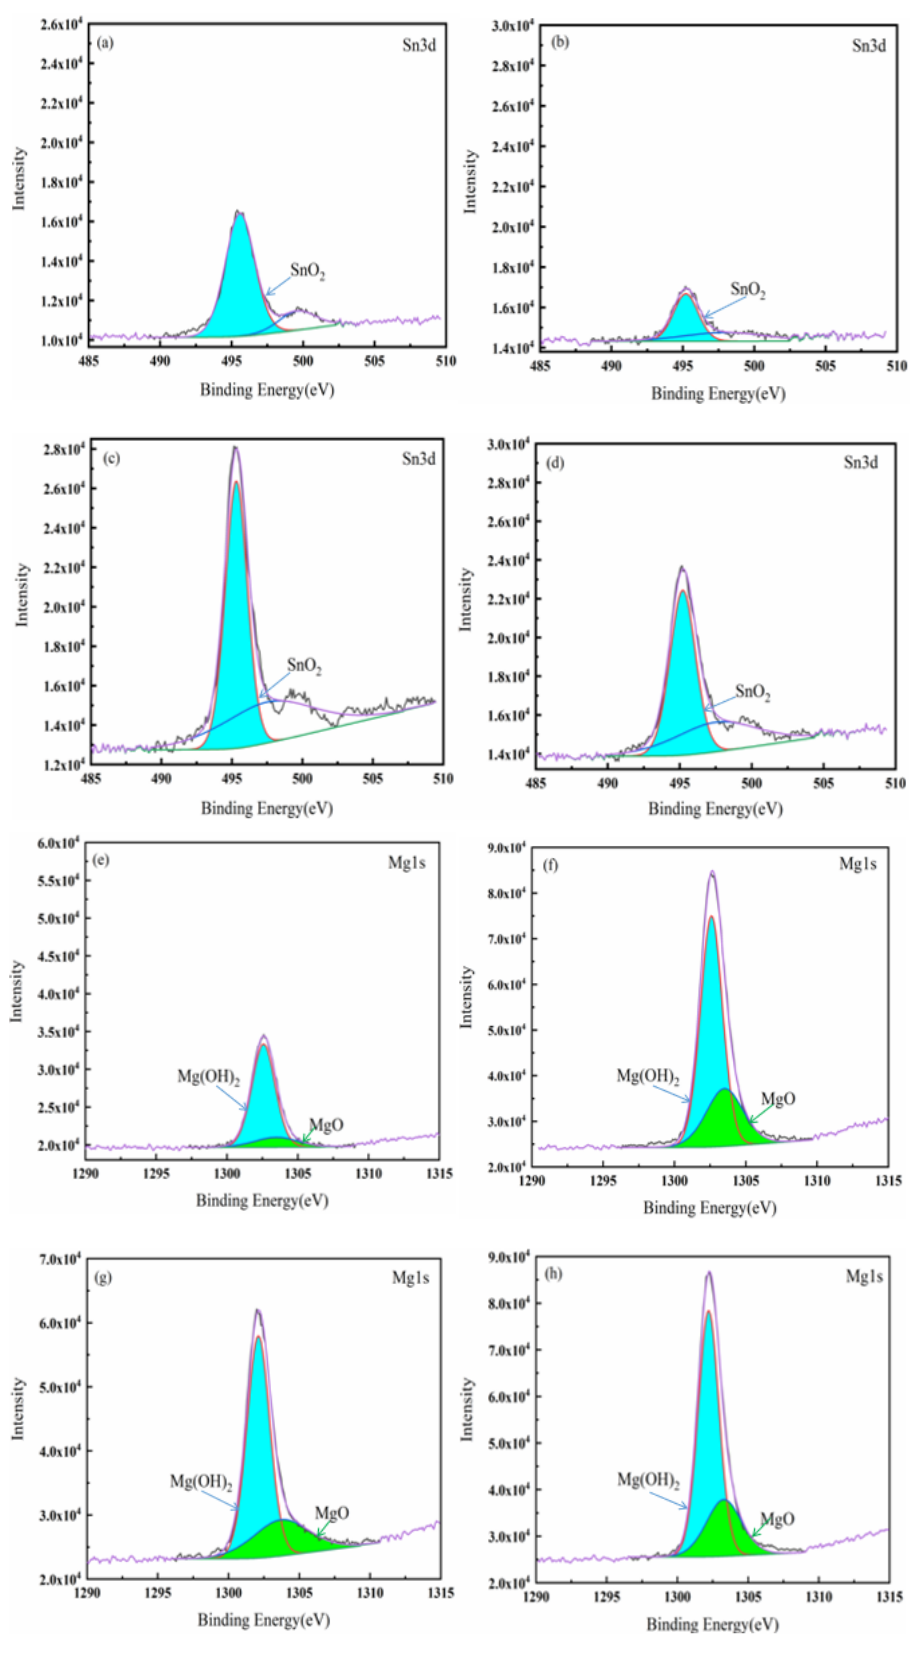
Figure 5. XPS surface analysis results of Mg- x Sn: ( a , e ) Mg-0.5Sn; ( b , f ) Mg-1Sn; ( c , g ) Mg-2.5Sn; and ( d , h ) Mg-4Sn.